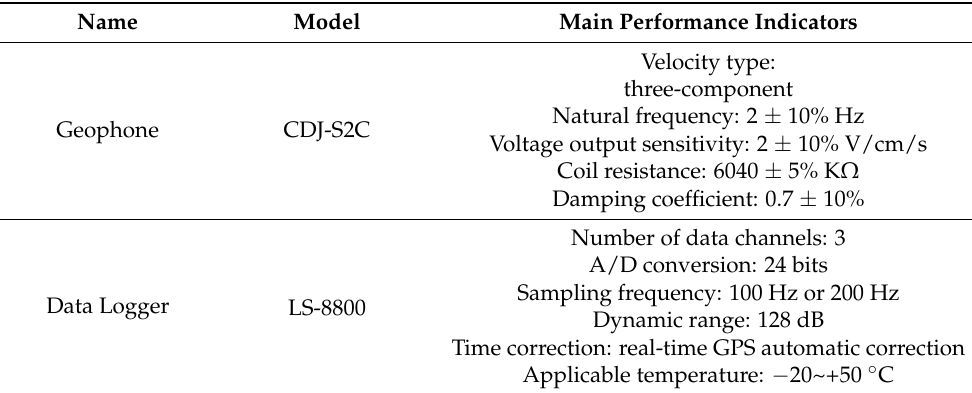
Figure 7. Schematic diagram of the test site and engineering drilling location. Table 5. The main performance indicators of independent microtremor